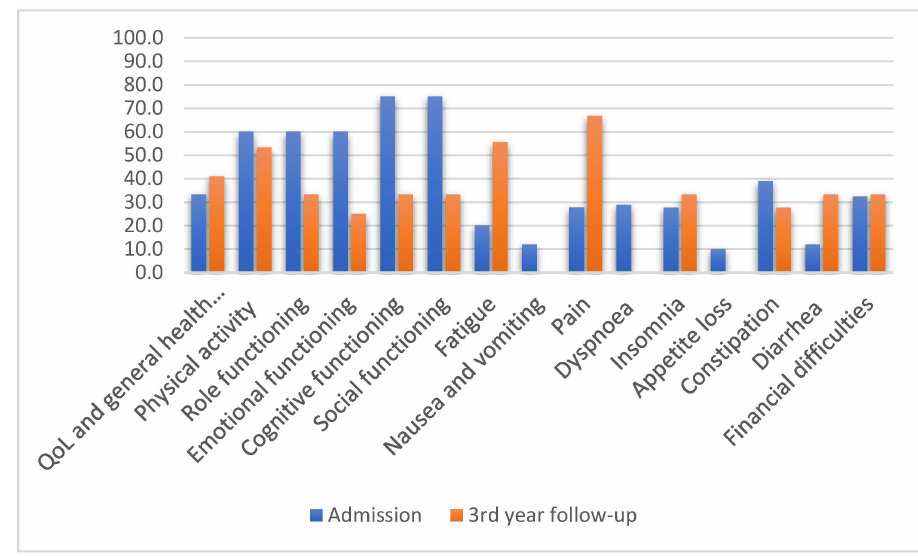
Figure 3. QLQ-C30 mean values after oral cavity cancer treatment (N =